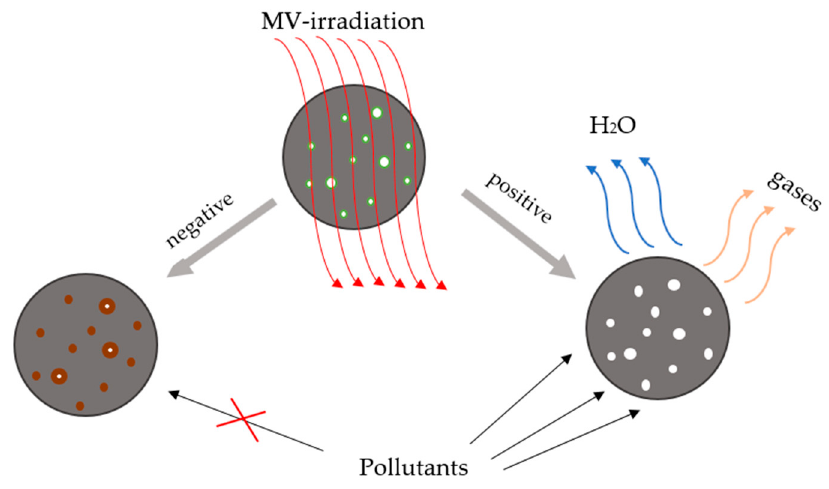
Figure 5. Scheme of the mechanism of the impact of microwave radiation on natural sorbents— positive and negative scenarios.